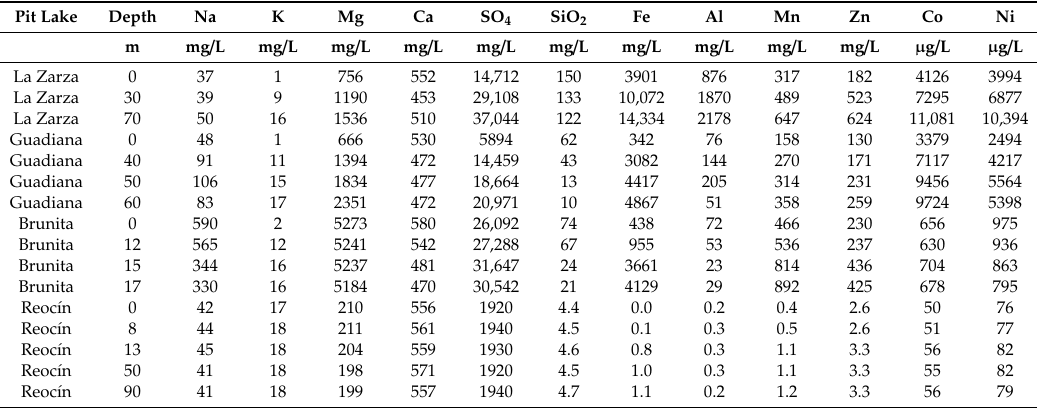
Table 1. Water chemistry (major cations, sulfate, silica and trace metals) at di ff erent depths in several pit lakes in Spain: La Zarza and Guadiana (massive sulfide mines, Huelva), Brunita (Zn-Pb-Fe-Ag mine, Murcia), and Reoc í n (Zn-Pb mine, Cantabria; taken from [33]). Pit Lake Depth La